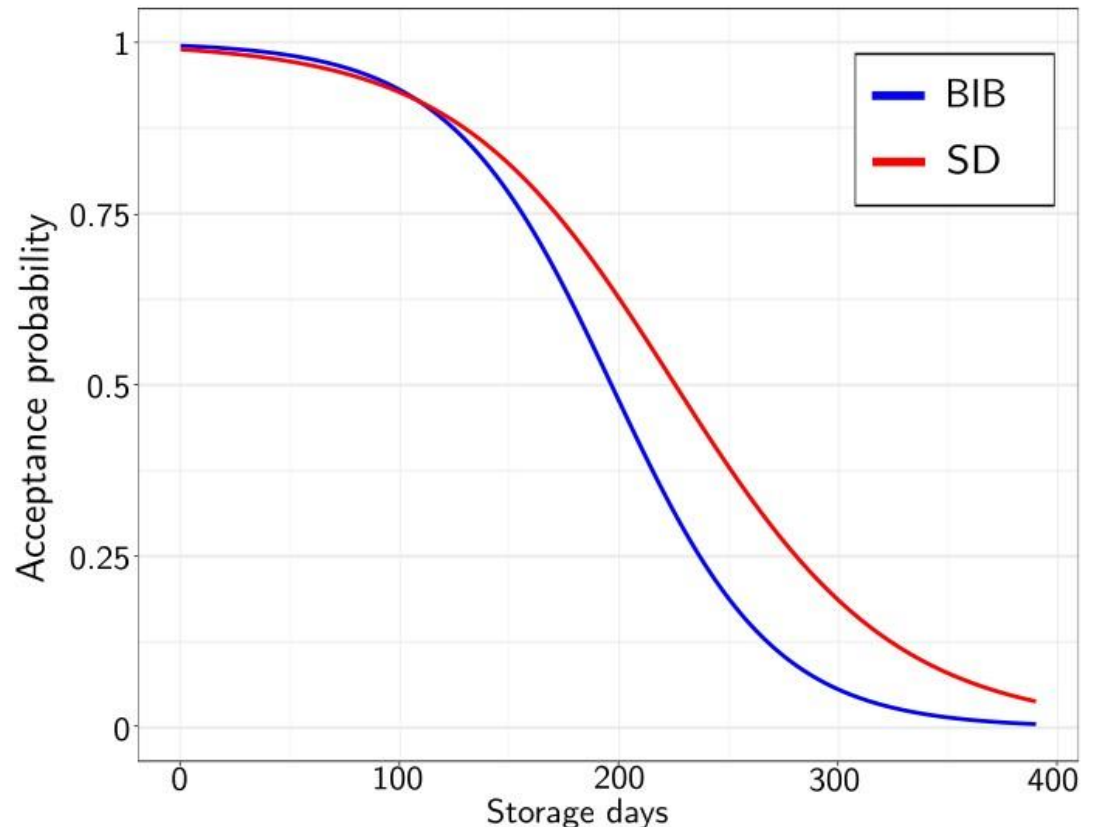
Figure 1. Survival analysis results of the BIB (blue) and SD (red) of acceptance probability against the storage time in days for the logarithmic model.